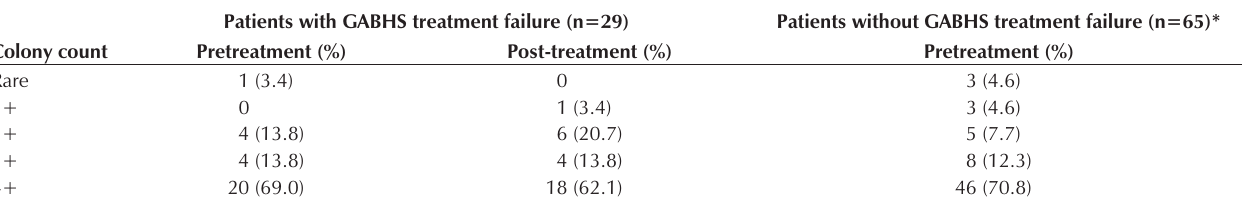
Frequency of colony counts on throat swabs taken at enrolment and follow-up for patients with and without treatment failure Patients with GABHS treatment failure (n=29) Patients without GABHS treatment failure (n=65)* Colony count